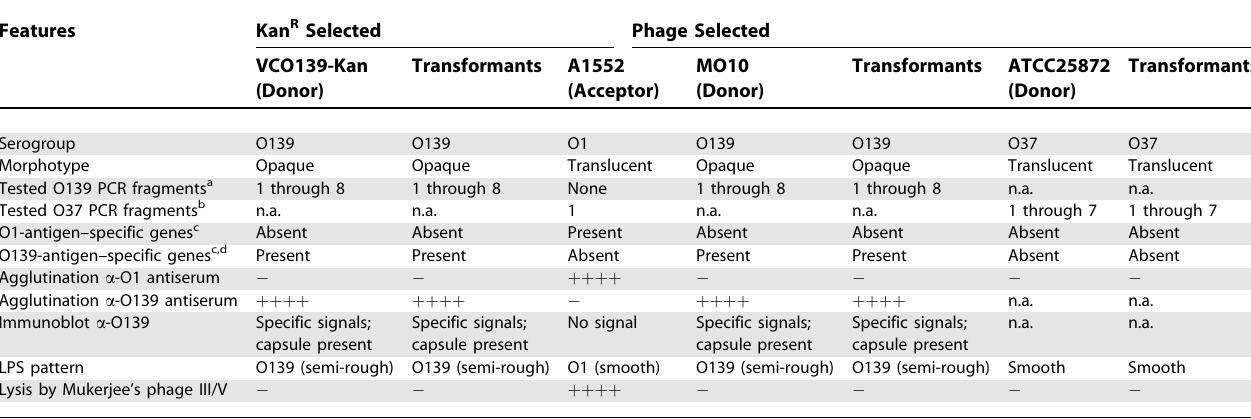
Table 1. Genotype and Phenotype of the Transformants